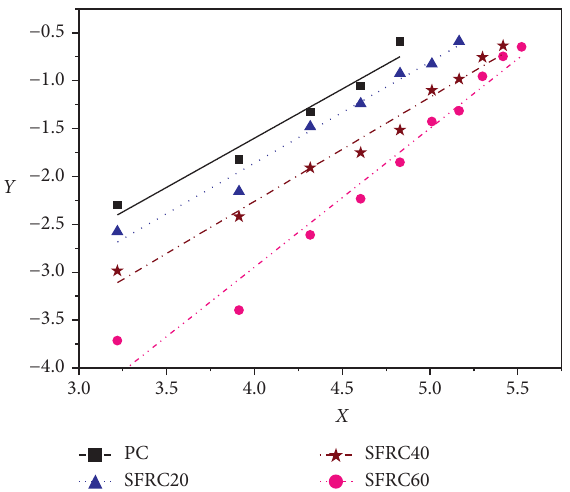
Figure 5: Linear regression of frost damage in Weibull distribution.